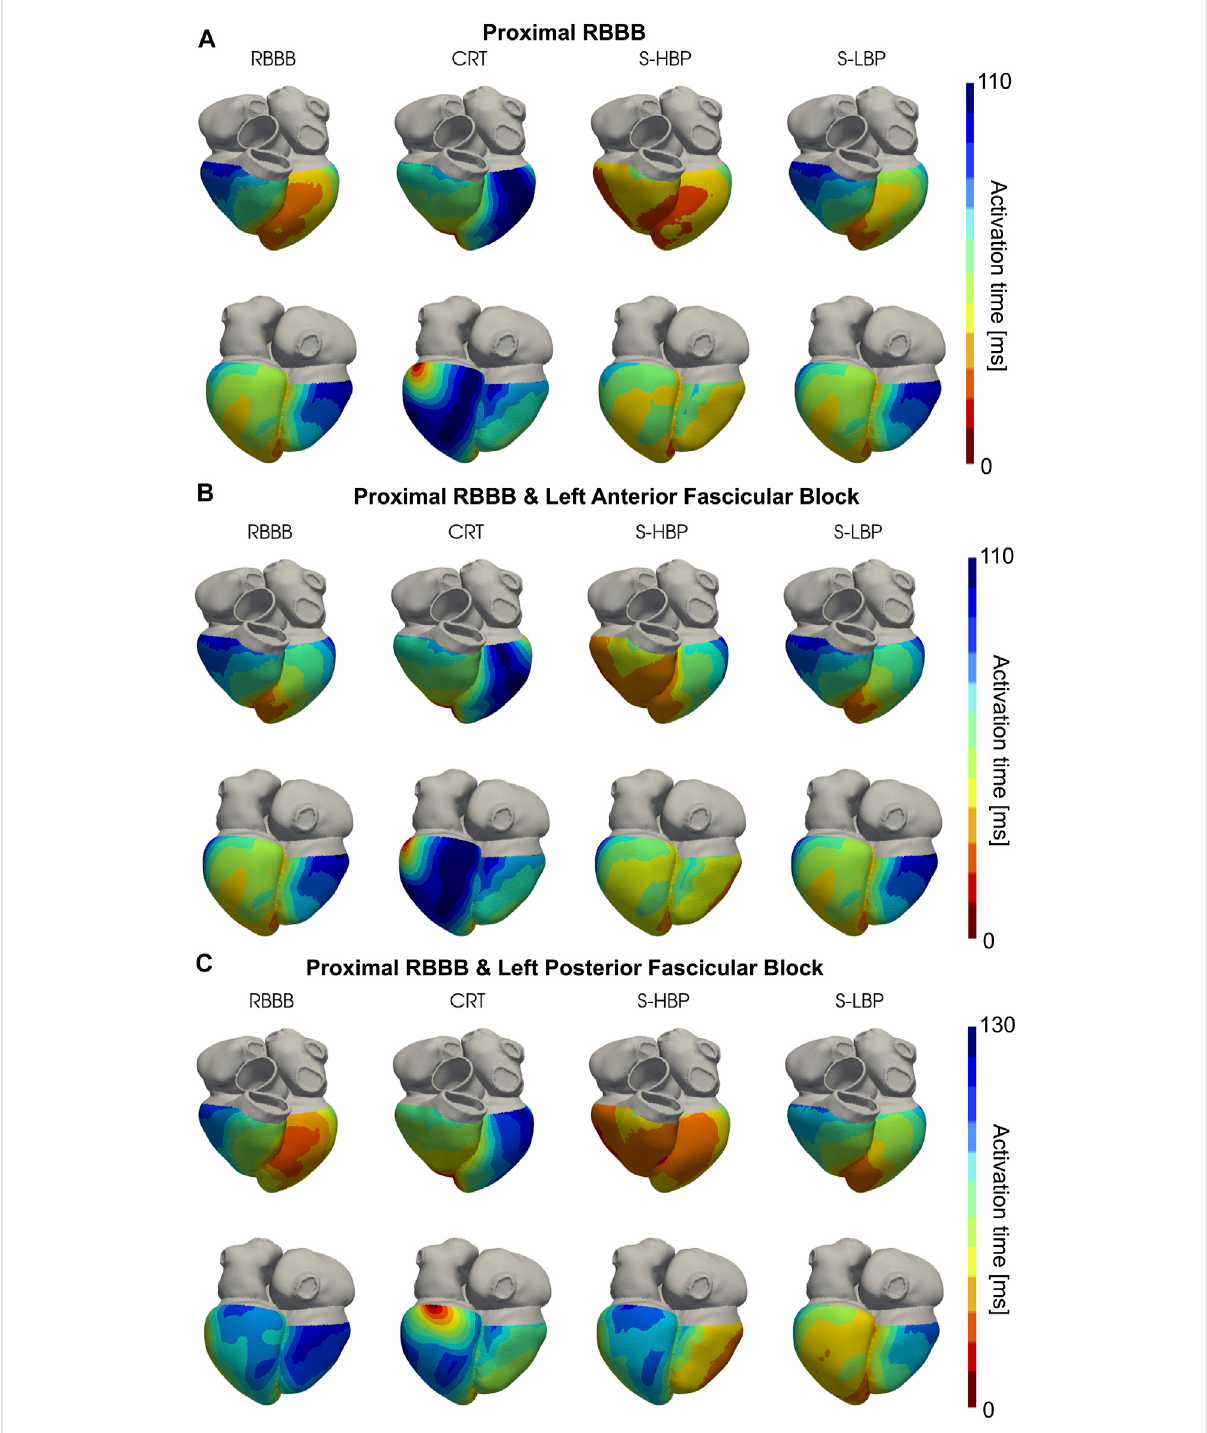
FIGURE 3 SimulatedActivationTimes:Activationtimessimulatedononeofthepatientsforbaseline,CRT,selectiveHBP(S-HBP)andselectiveLBP(S-LBP) in the presence of proximal RBBB combined with: (A) otherwise normal His-Purkinje system, (B) left anterior fascicular block and (C) left posterior fascicular